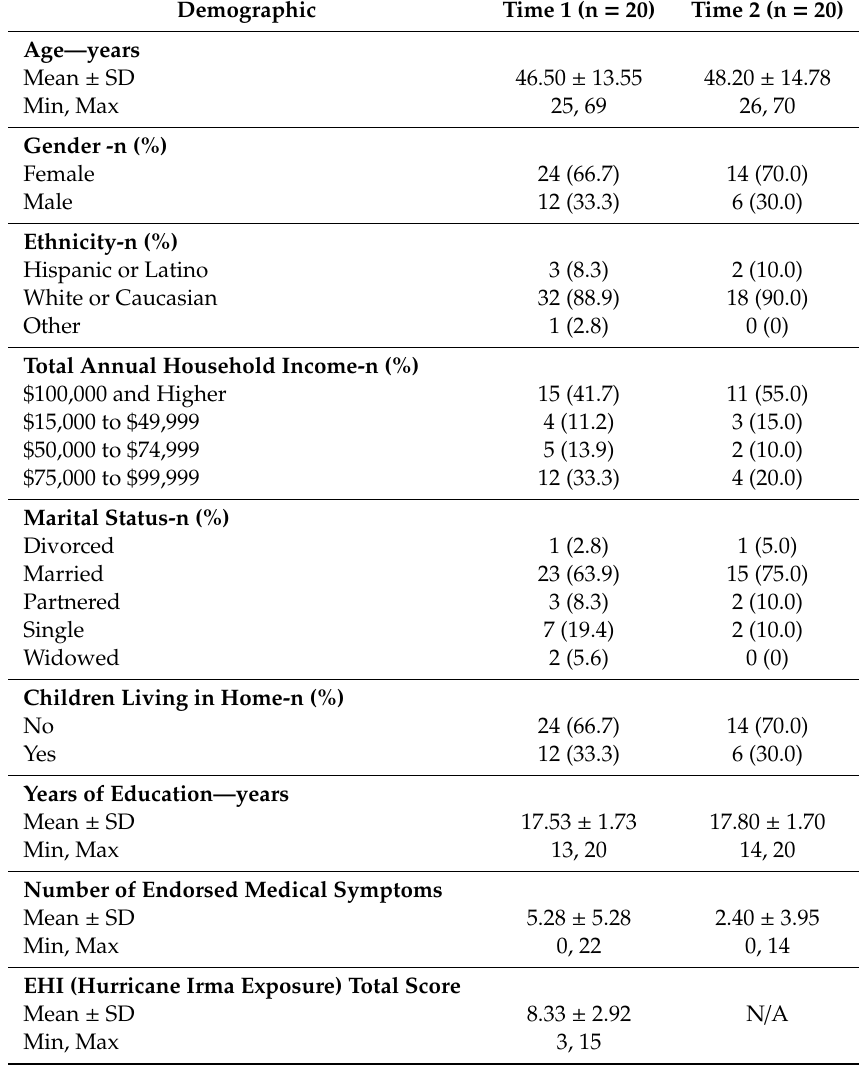
Table 1. Demographic and hurricane exposure information for Extension Agents after 3 to 8 weeks (Time 1) and one year (Time